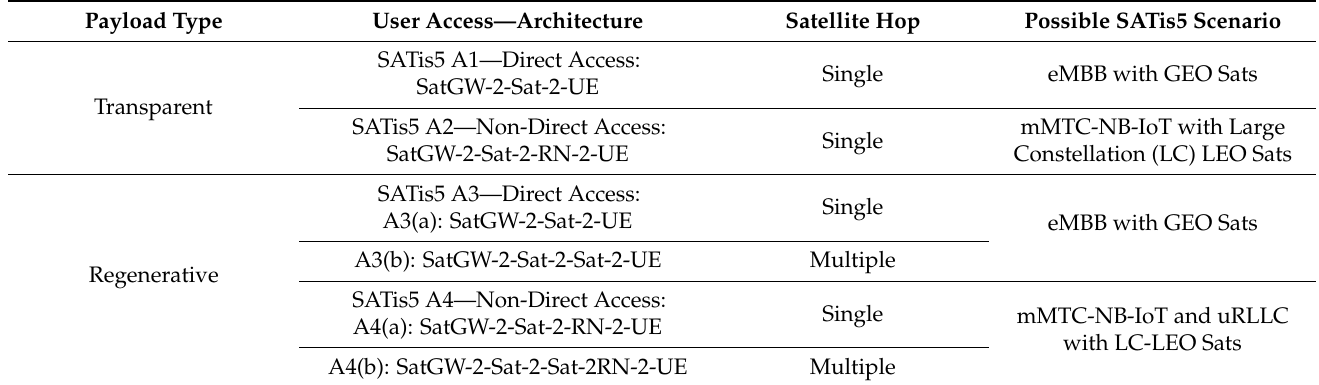
Table 2. Summary of Four Baseline SATis5